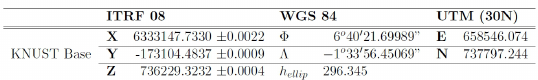
In accepting the ZTD values computed with gLAB, a comparison with International GNSS Service (IGS) ZTD